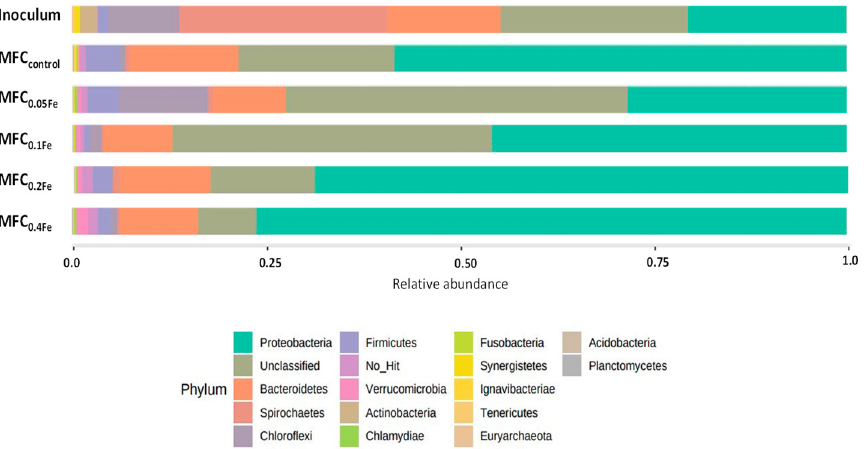
Figure 6. Relative abundance of particular phyla in the inoculum and anodic biomass obtained from all MFCs. A common feature of the microbiome in all MFCs was the presence of Acidovorax sp. during reactor start-up (Figure 7). Its share ranged from 3 to 18.5% depending on the MFC, and then, in subsequent cycles, it decreased to <0.5%; only in the control did its share amount to 1.3% in the 18th cycle. Acidovorax sp. are capable of efficient extracellular poly- meric substances (EPS) production (over 150 mg/L in R2A agar medium [66]), and proba- bly participated in anode colonization and the formation of an anode biofilm in the initial stage of MFC operation.